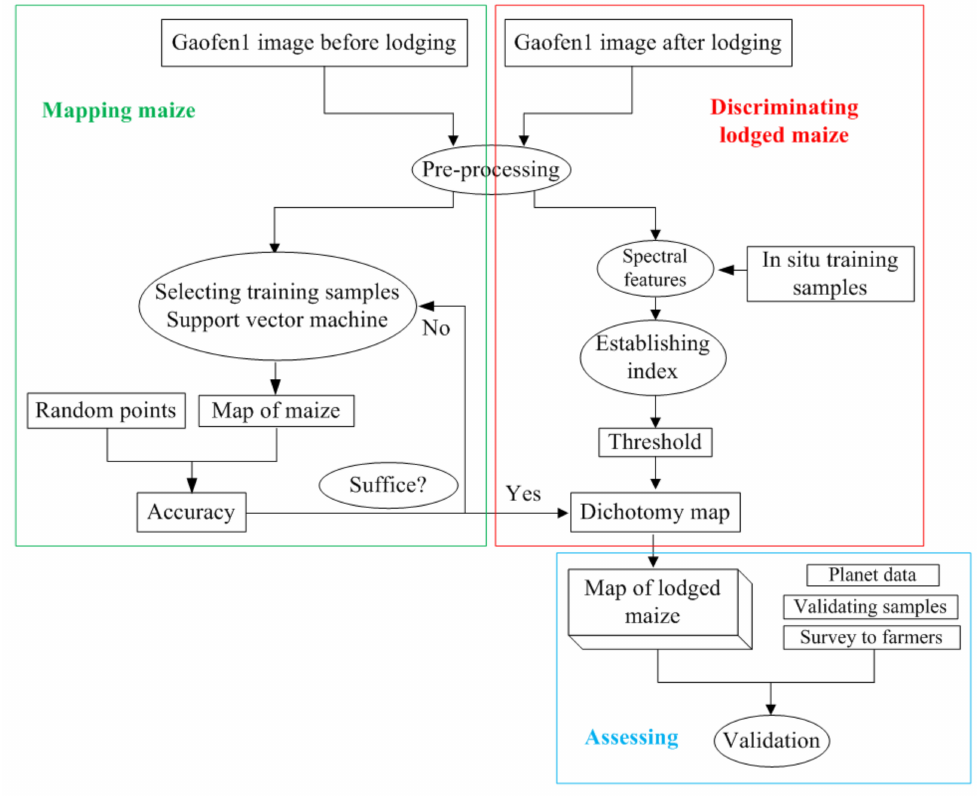
Figure 4. The workflow of lodged maize